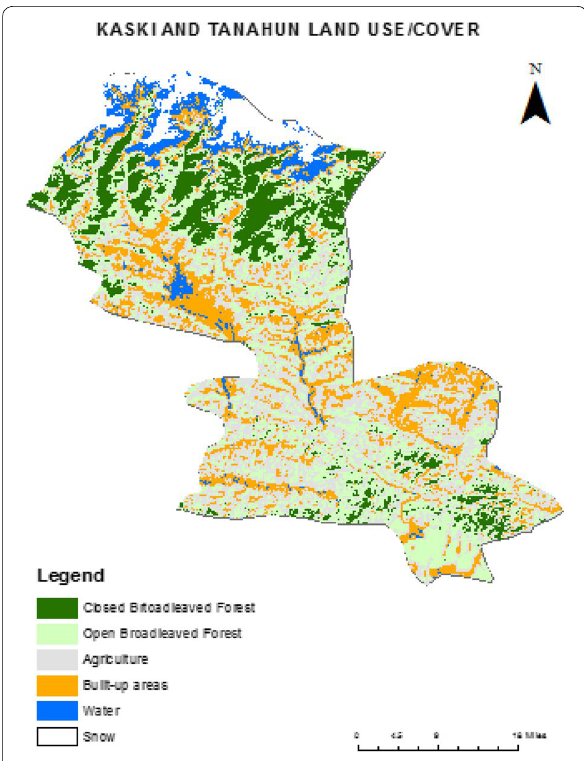
Fig. 13 Land-cover mapping classes for Kaski–Tanahun districts (2015)